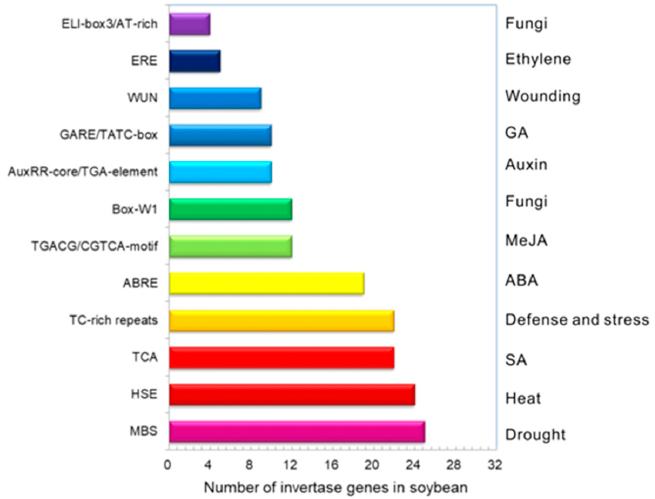
Figure 3. Prediction of the various cis-acting elements involved in environmental stresses and phytohormone responsiveness. ABRE (ABA-responsiveness), MBS (drought inducible MYB-binding site), TGACG/CGTCA-motif (MeJA-responsiveness), TCA-element (SA responsiveness), WUN-motif (wound-responsive element), TC-rich repeats (defense and stress responsiveness),